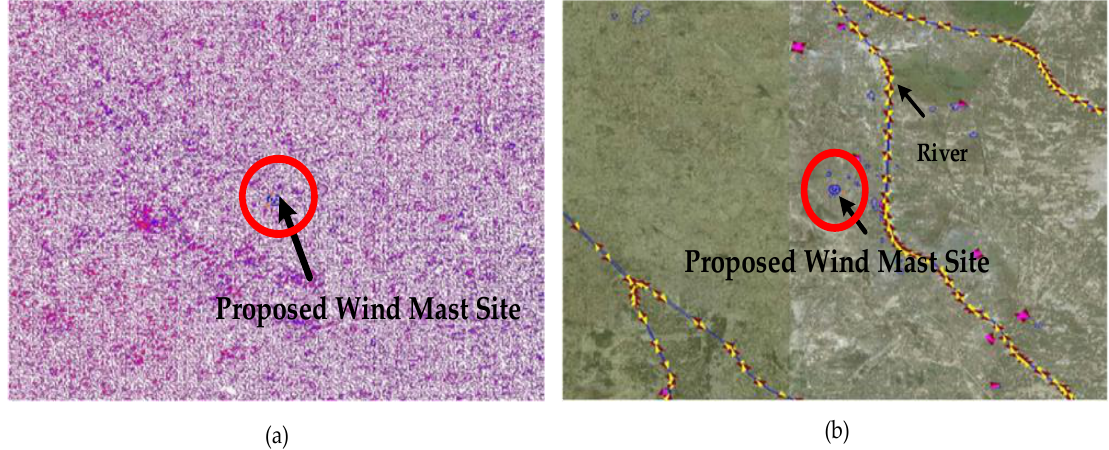
Figure 6. Topographic maps for Sanghar site. ( a ) Elevation map 20 × 20 km (with mast in center) with 10 m elevation difference between lines. Altitudes in map range from 13 m to 25 m (warmer colors indicate higher altitudes). RIX value at mast is 0% using radius of 3500 m, steepness threshold of 30% (17 ◦ ) and frequency distributed directional weight. ( b ) Ground roughness map 20 × 20 km (with mast in center). Background roughness length is 0.07 m, corresponding to open field with distributed rows of trees and low buildings. Roughness length for specific areas is 0.5 m for towns (rose color), 0 m for rivers (yellow color).